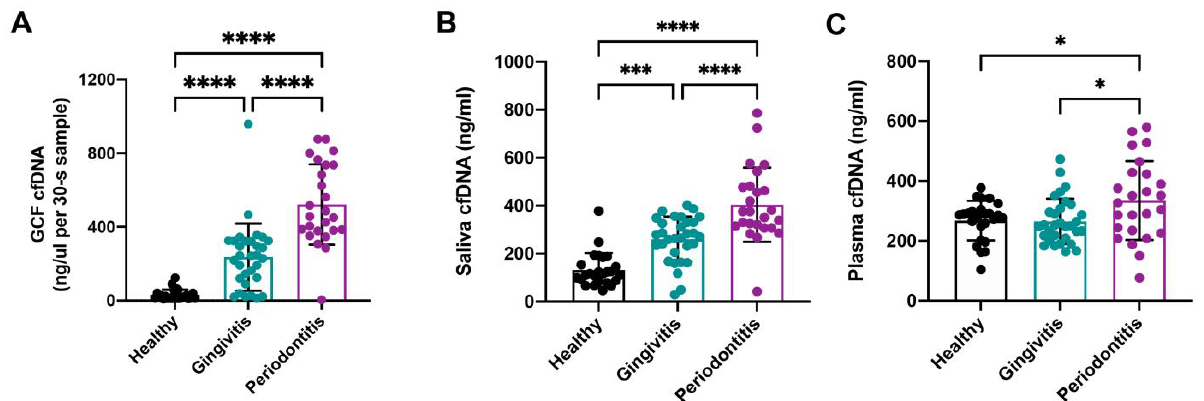
Figure 1. Comparison of cfDNA concentrations in GCF (ng/ µ l per 30-s sample), saliva (ng/mL), and plasma (ng/mL) in different states of periodontal inflammation. ( A ) Comparison of GCF cfDNA in different periodontal states. ( B ) Comparison of saliva cfDNA in different periodontal states. ( C ) Comparison of plasma cfDNA in different periodontal states. (Abbreviation: cfDNA, cell-free DNA; GCF, gingival crevicular fluid. n = 25 (healthy), 31 (gingivitis) and 25 (periodontitis). Differences were assessed via one-way ANOVA with Tukey’s multiple comparison tests. * p < 0.05; *** p < 0.001; and **** p < 0.0001).